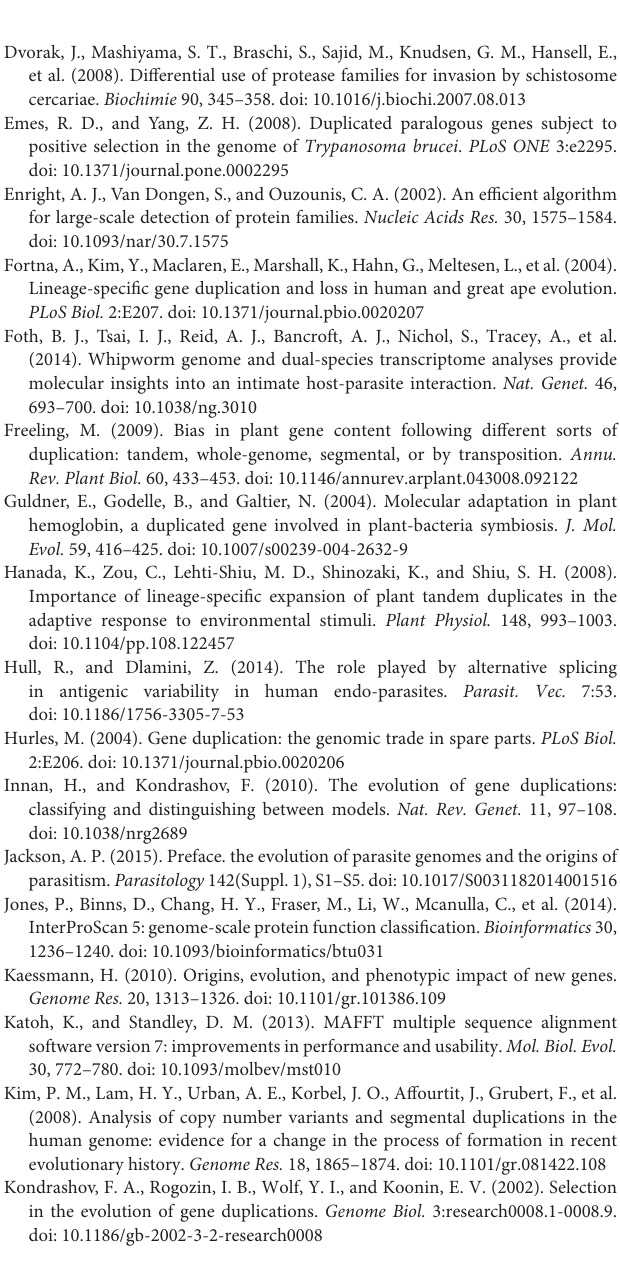
Supplementary Table 5 | Annotations of genes generated from tandem duplications. Supplementary Table 6 | Positively selected genes identified by pair-wise comparison. Supplementary Table 7 | Positively selected gene families identified by site model